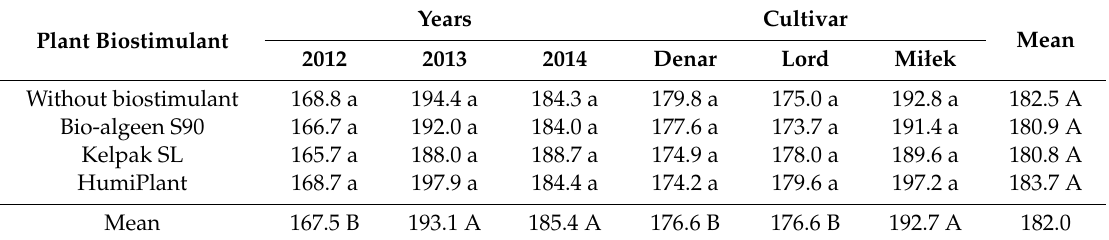
Table 4. Dry matter content in potato tubers; g · kg − 1 FW.